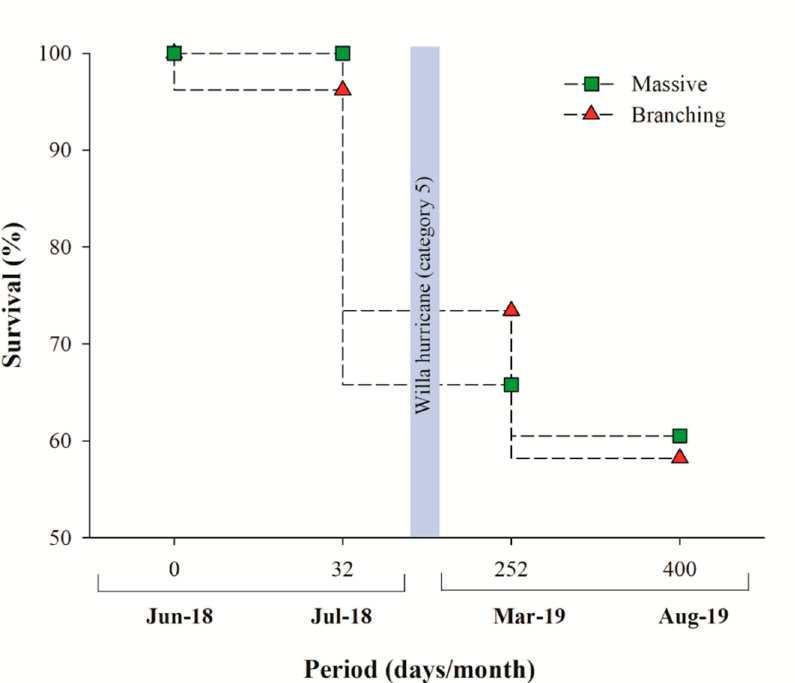
Figure 4. Coral survival (%) for Pavona clavus (green squares) and Pocillopora species (red triangles) during the 13-month in situ period. The vertical grey bar depicts Hurricane Willa date (118 restoration days).